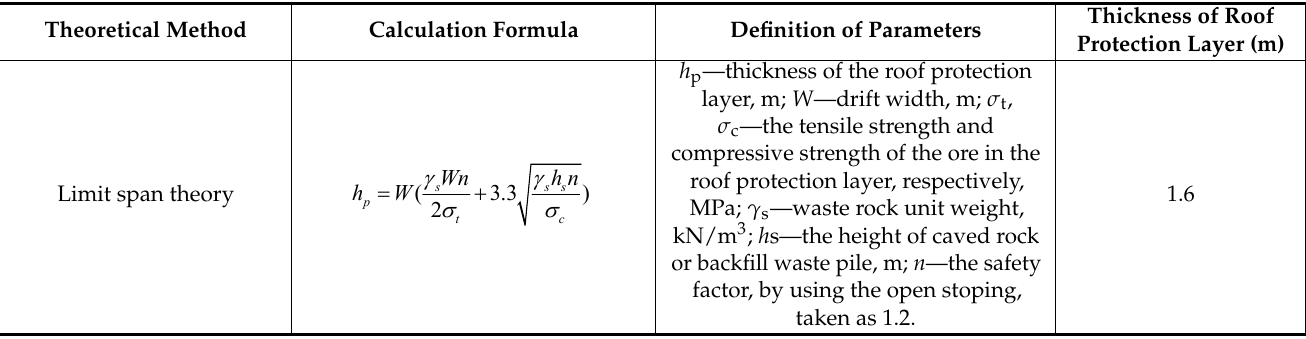
Table 2. Theoretical calculation methods and results.